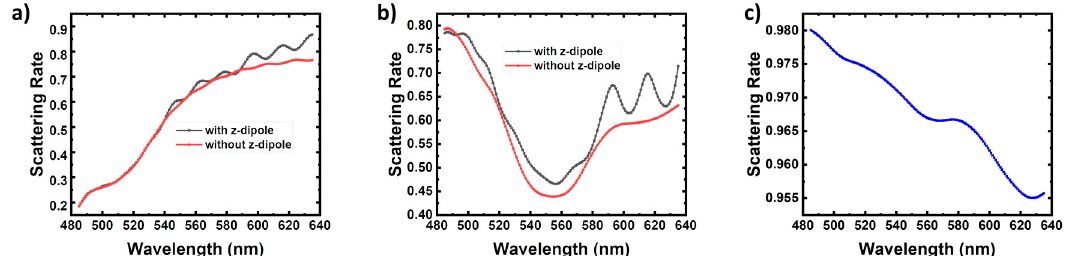
Figure 6. Average scattering rate spectra of the q-dipoles for Points ( a ) A, ( b ) B, and ( c ) C. All the scattering rates are calculated using the perturbation method and weighted averaged by the F p values with ϕ increasing from 0 ◦ to 180 ◦.